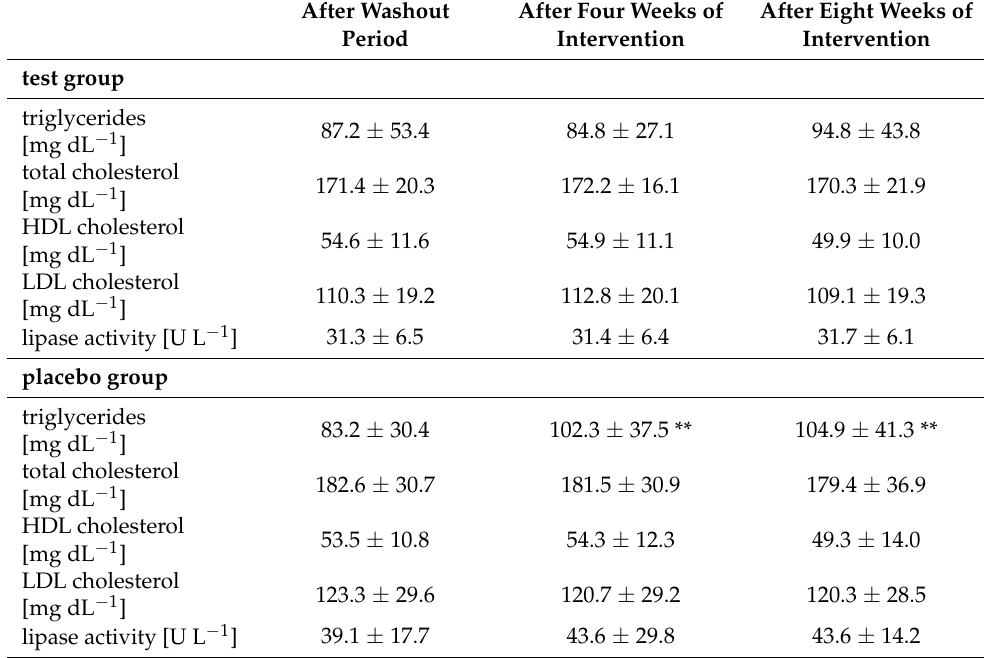
Table 4. The blood lipid profiles and lipase activity of the participants throughout the study. Data are presented as mean values and SD. Significant differences in comparison to the washout period: ** p < 0.01.